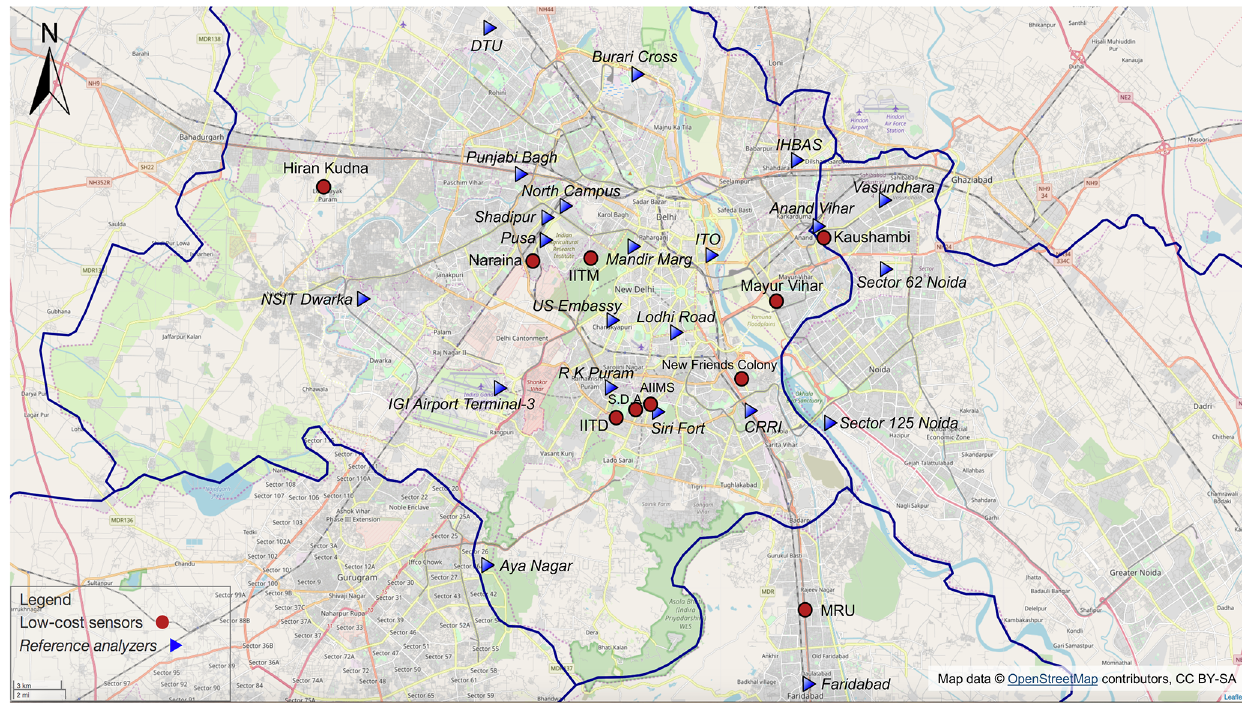
Figure 2. Locations of the 22 reference nodes (triangles with italic text) and 10 low-cost nodes (circles) that form the Delhi PM